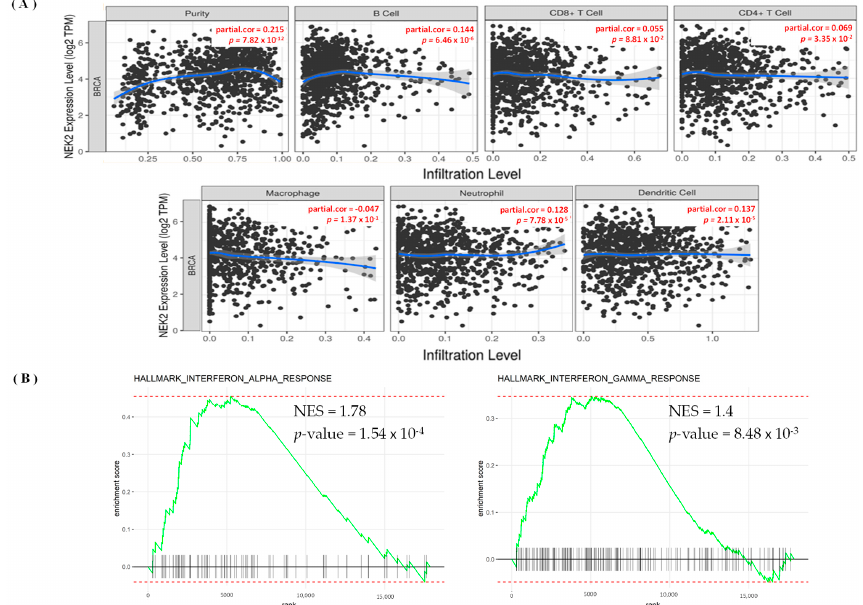
Figure 9. ( A ) Scatterplot of correlations among expressions of the NEK2 gene and levels of immune infiltration in breast cancer. Correlation of NEK2 with levels of immune infiltration (purity, B cells, CD8 + T cells, CD4 + T cells, macrophages, neutrophils, and dendritic cells). The correlation measurement is indicated by the partial correlation value using Spear- man’s partial rho and the statistical significance of the p value. ( B ) GSEA analysis suggested that NEK2 expression could regulate the interferon alpha and gamma signaling in breast cancer.